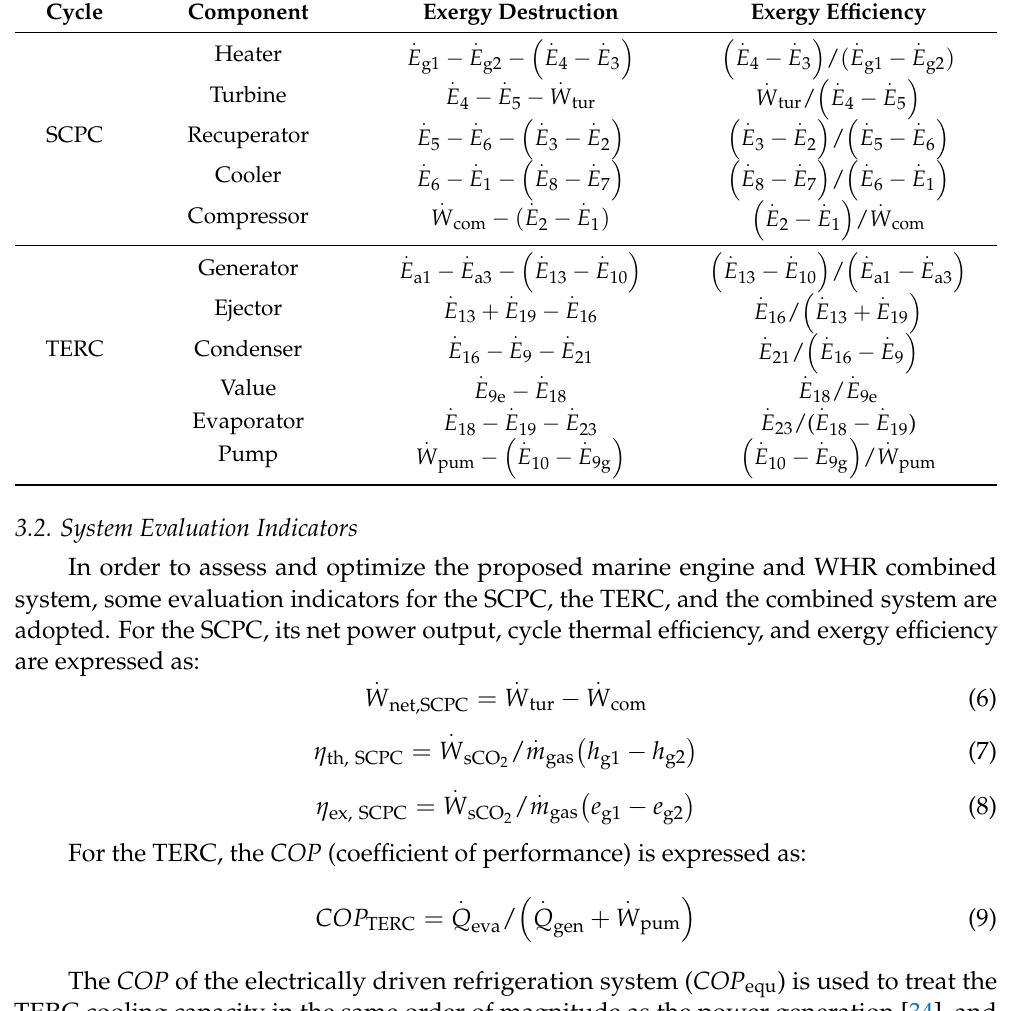
Table 3. Exergetic balance equations of each component in the proposed WHR system. Cycle Component Exergy Destruction Exergy Efficiency